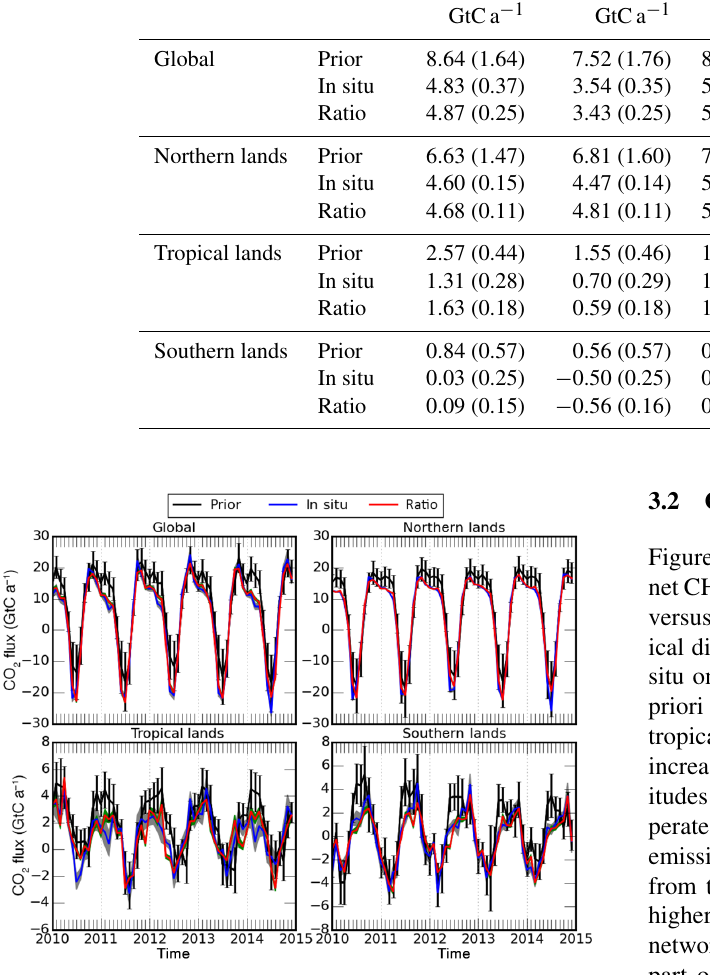
Figure 3. The net monthly CO 2 fluxes inferred by the in situ only inversion (blue) and the ratio inversion (red), compared to the prior estimates (black). The vertical lines (envelopes) represent the prior (posterior) uncertainties. In the plots, we aggregate CO 2 fluxes of all four categories to the net monthly values over four predefined global regions (Fig. 1): (a) global, (b) northern lands, (c) tropical lands, and (d) southern